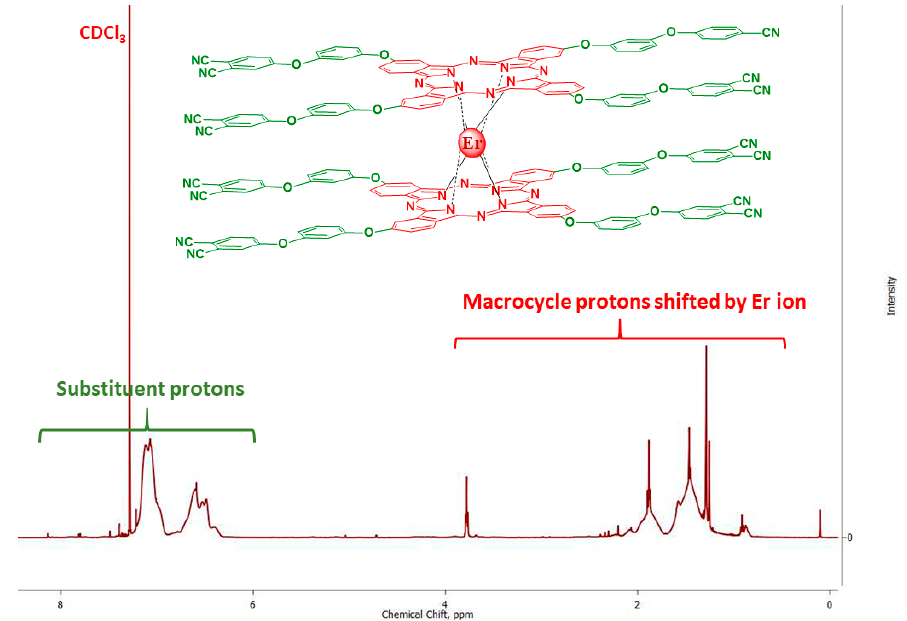
Figure 4. 1 H-NMR spectrum of bistetrakis-4-[3-(3,4-dicyanophenoxy)phenoxy]phthalocyaninato erbium ( 3 ) in CDCl 3 (the atoms most affected by the central metal atom are highlighted in red, the least in green).